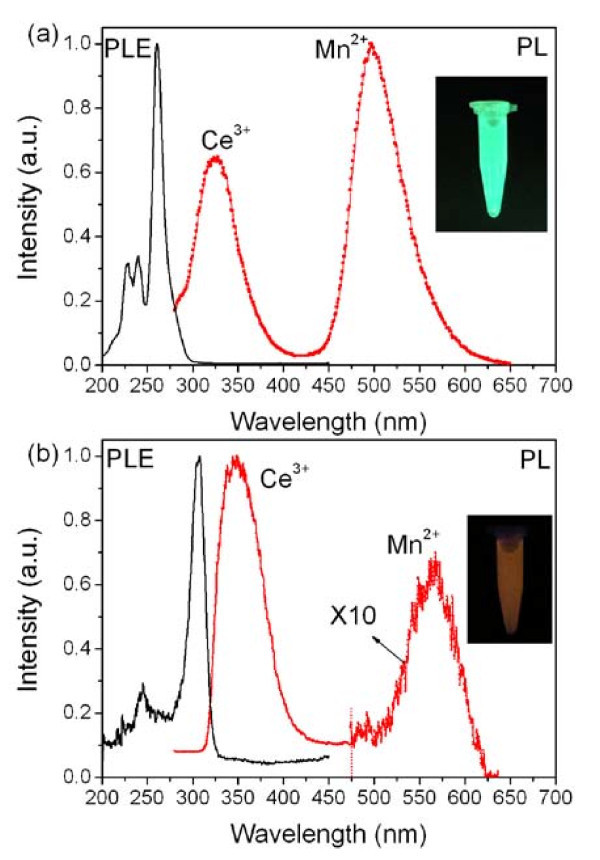
PLE and PL spectra. PLE and PL spectra of CeF3:Mn (a) and CePO4:Mn (b) NCs.